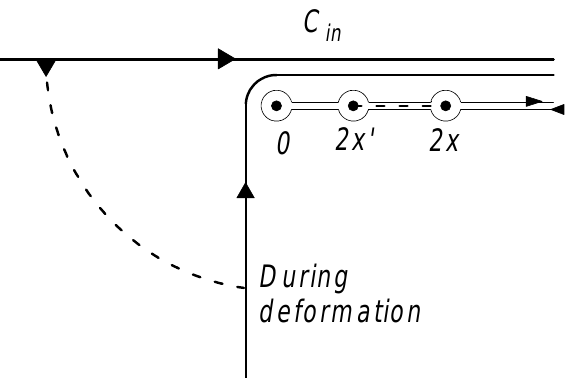
FIG. 1. The deformation of the integration contour in Eq. (31). The dashed line shows the part of the cut in